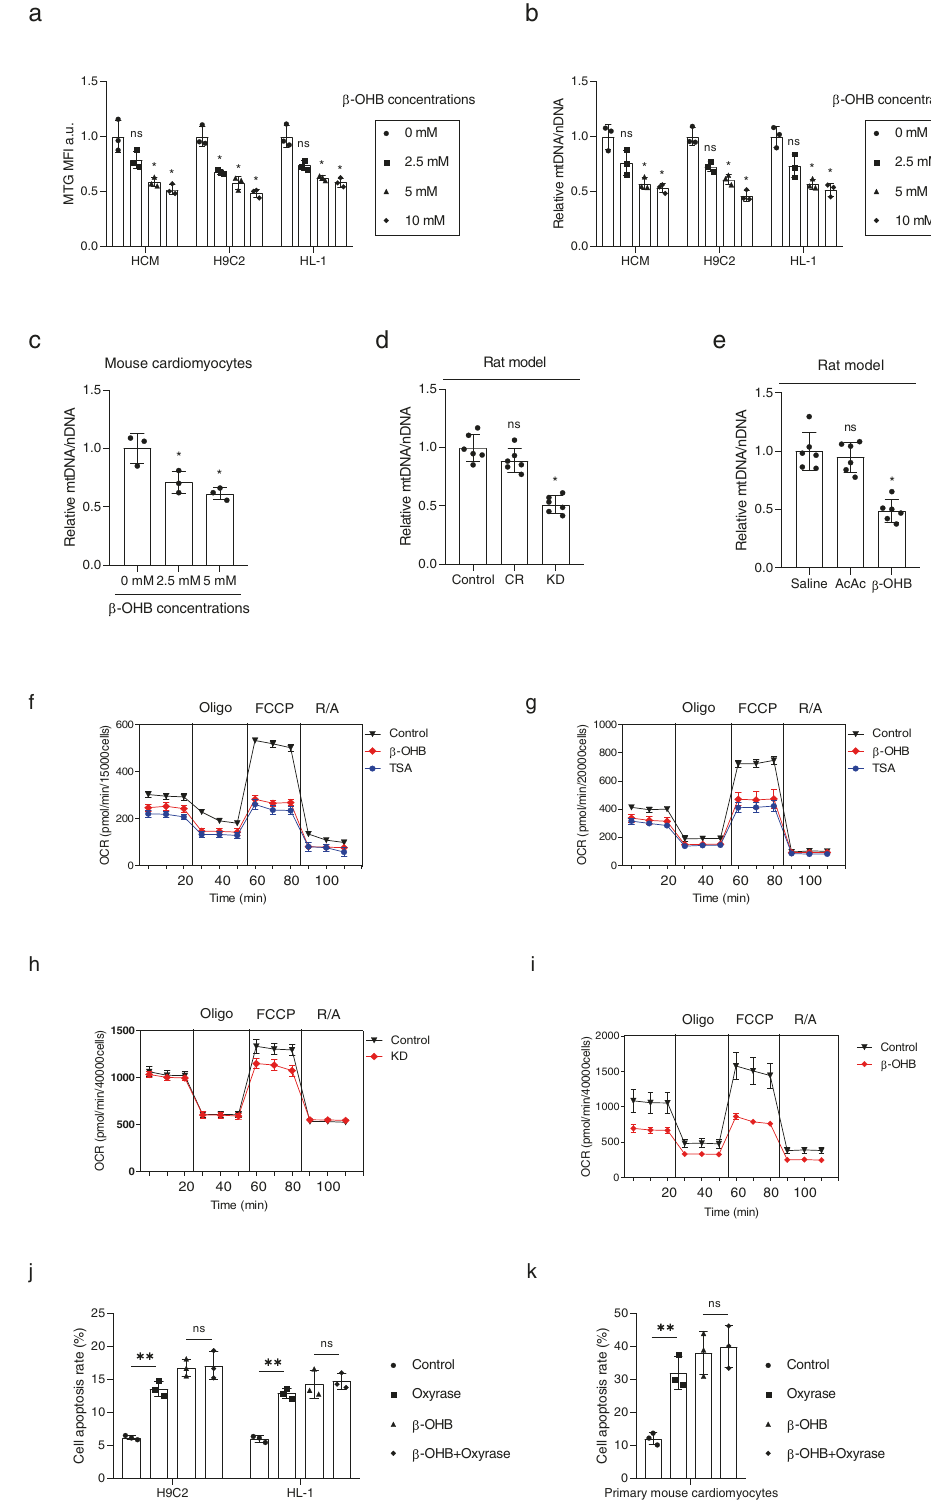
Fig. 3 Increased β -OHB decreased mitochondrion levels. a , b Mitochondrial mass, as determined by MitoTracker Green staining ( a ) and mitochondrial DNA quanti fi cation ( b ) in cells with different concentrations of β -OHB; n = 3. c Mitochondrial mass determined by mitochondrial DNA quanti fi cation in mouse primary cardiomyocytes; n = 3. d , e Mitochondrial mass determined by mitochondrial DNA quanti fi cation in atrial tissues from rats with different treatments; n = 6/group. f , g Oxygen consumption rates (OCRs) in H9C2 ( f ) and HL-1 ( g ) cells treated with β -OHB or trichostatin A (TSA). h , i OCRs in primary cardiomyocytes isolated from the atrial tissues of rats with various treatments. j , k Apoptosis in cell lines and primary mouse cardiomyocytes treated with β -OHB and oxyrase; n = 3. Data shown are means ± standard errors. ns p > 0.05, * p < 0.05, ** p < 0.01, *** p < 0.001 versus the corresponding control group according to Student ’ s t